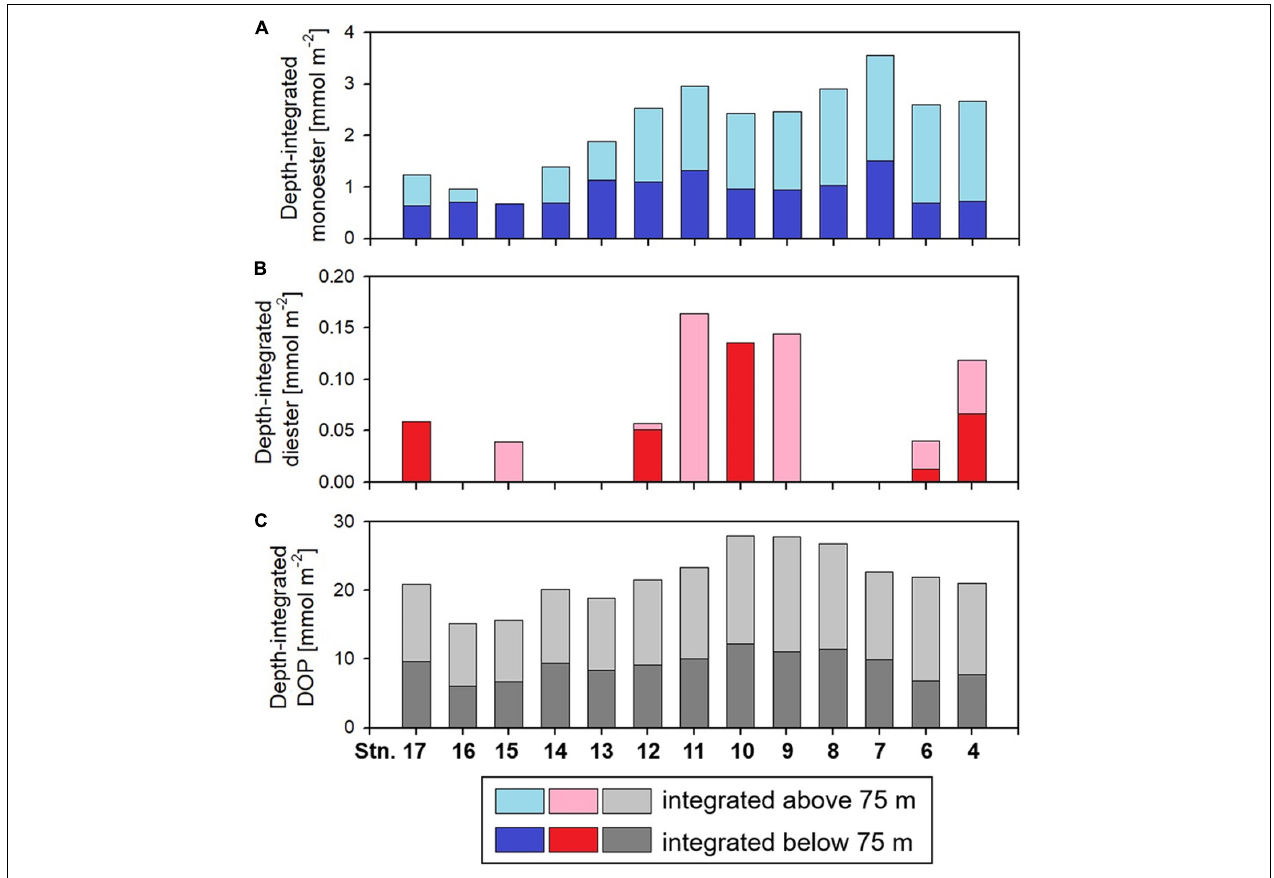
FIGURE 5 | Distributions of the depth-integrated amount of (A) monoester, (B) diester, and (C) dissolved organic phosphorus (DOP). At the two eastern stations 4 and 6, these parameters were integrated only above 110 and 104 m, respectively, due to lacking data